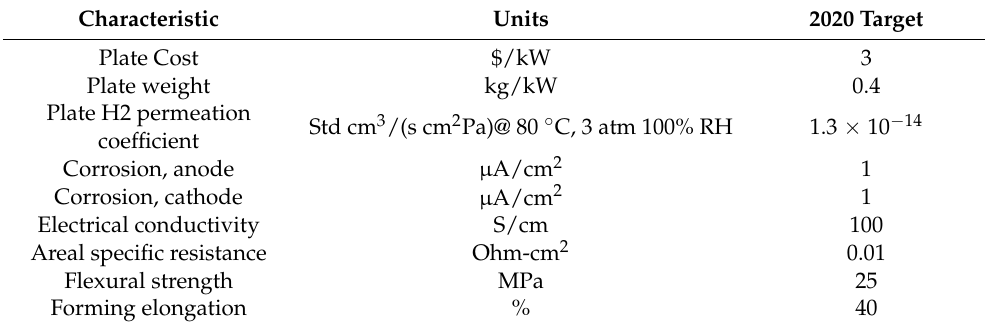
Table 2. Technical targets for